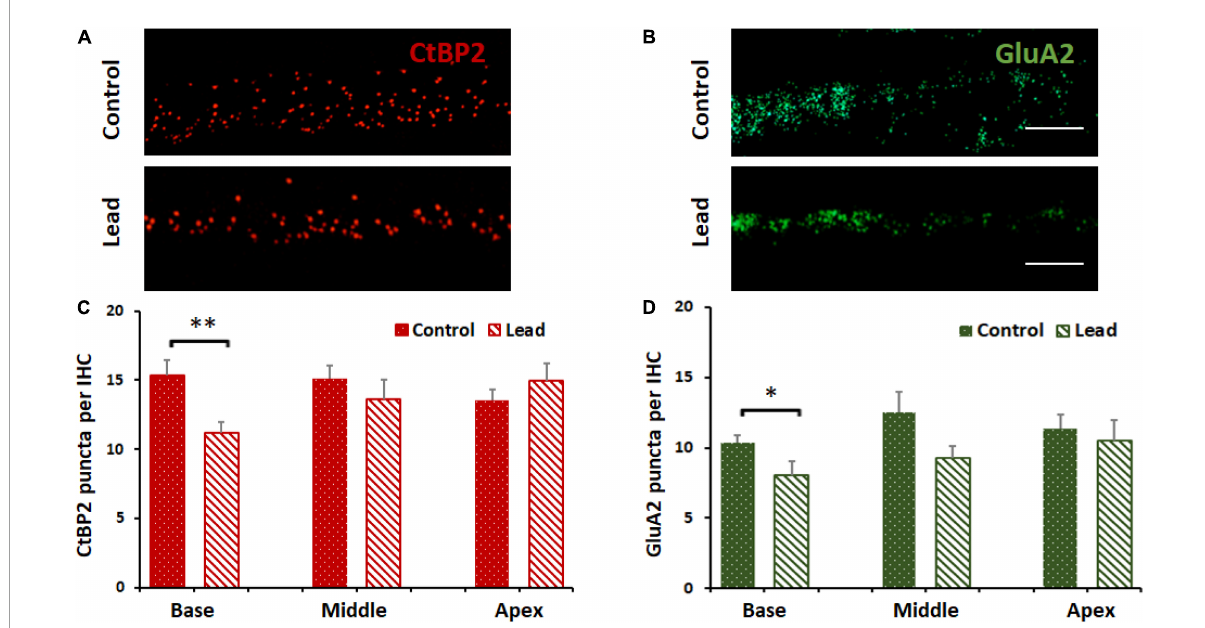
FIGURE4 Lead-induced disruption of cochlear ribbon synapses. (A) Inner hair cells in the basal region of the organ of Corti probed with antibodies against C-terminal binding protein 2 (CtBP2, red stain) are illustrated. Lead exposure decreased the expression of this pre-synaptic marker in the inner hair cell synapses. Images are representative of 5–8 replicates, scale bar = 20 µ m. (B) Inner hair cells in the basal region of the organ of Corti probed with antibodies against glutamate receptor subunits 2 (GluA2, green stain) are illustrated. Lead exposure decreased the expression of this post-synaptic marker in the inner hair cell synapses. Images are representative of 5–8 replicates, scale bar = 20 µ m. (C,D) Counts of CtBP2 and GluA2 puncta indicated that lead exposure decreased the counts significantly in the basal region of the inner hair cells (IHC, n = 5–8). * p < 0.05, ** p < 0.01. The results are expressed as mean ± standard error mean, n =